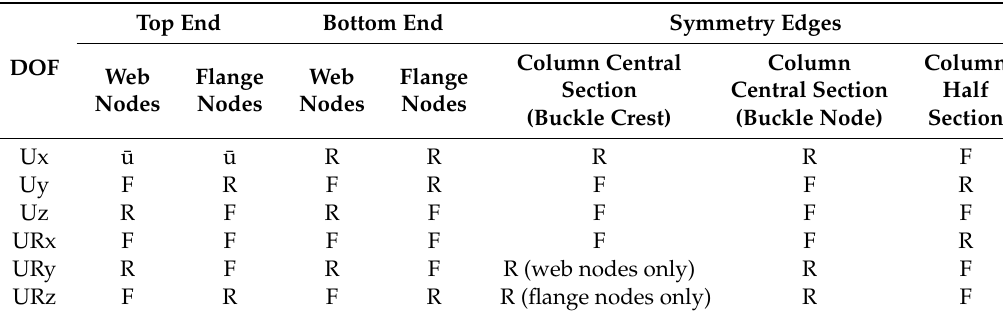
Table 1. Summary of boundary conditions.